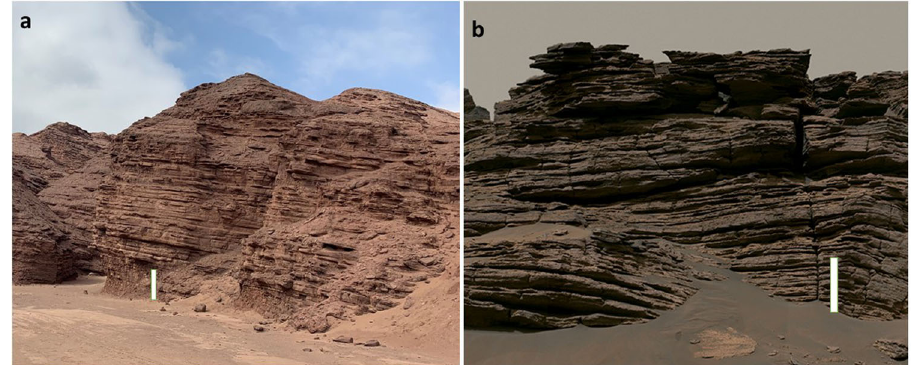
Fig. 1 | Comparison of the morphology of the Red Stone delta deposits with similar morphology of the delta deposits in Jezero Crater, Mars. a Red Stone depositfrompanoramaimagecourtesyofArmandoAzua-Bustos. b Asectionofthe panoramic composite image [image PIA24921_MAIN-20k.jpg] of the Jezero delta